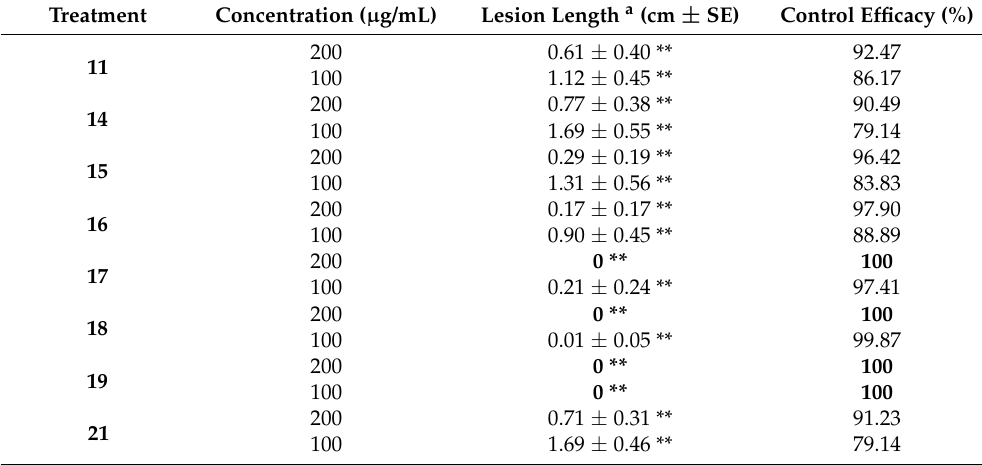
Table 3. In vivo protective activity against Rhizoctonia solani using detached leaf assay.